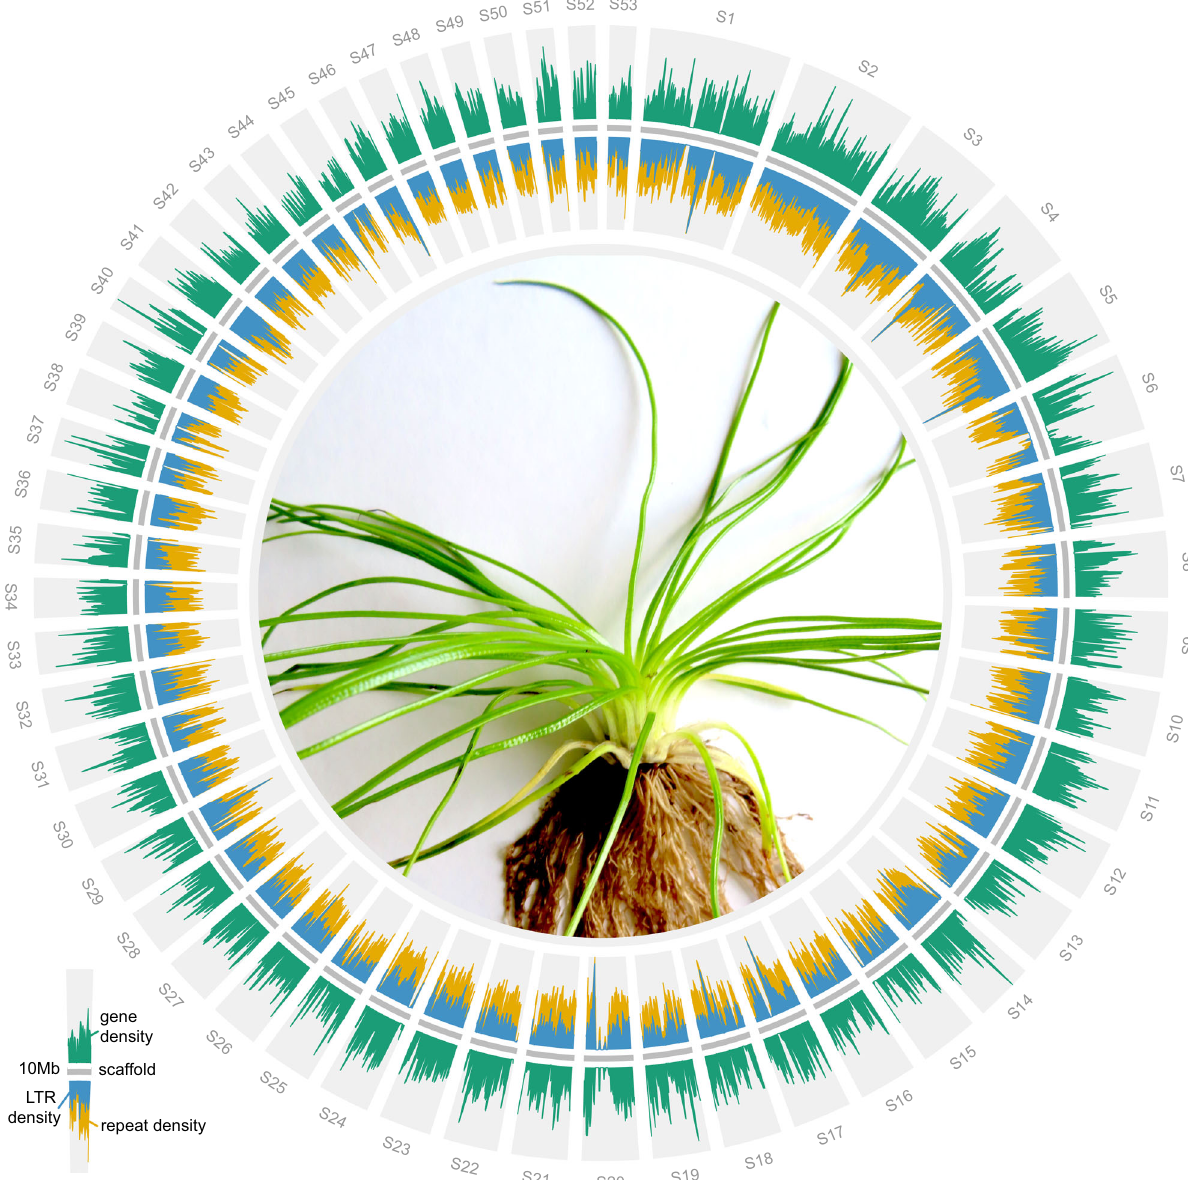
Fig. 1 Distribution of genes and repetitive elements in I. taiwanensis . The relatively even distributions differ from angiosperm genomes, but are similar to what have been reported in other seed-free plants. Only scaffolds longer than 10 Mb are plotted. Center: an image of I. taiwanensis . Source data are provided as a Source Data fi